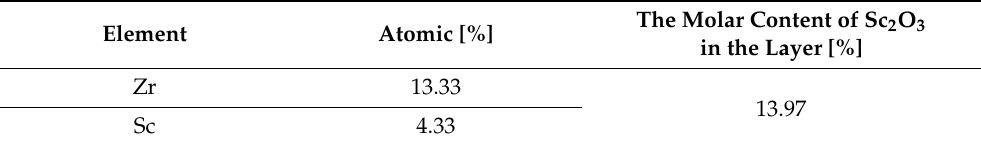
Figure 8. X-ray diffractogram of the layer obtained at 700 °C (presented in Figure 7) . Data included in Table 6 indicate that the layer contains zirconium and scandium. The molar content of Sc 2 O 3 in the layer is 13.97%. Table 6. Average chemical composition determined by EDS analysis and calculated molar content of Sc 2 O 3 in the layer (Figure 7). The synthesis temperature: 700 °C. Total gas pressure: 6580 Pa. The molar content of Sc(tmhd) 3 in the gas mixture: 28%.